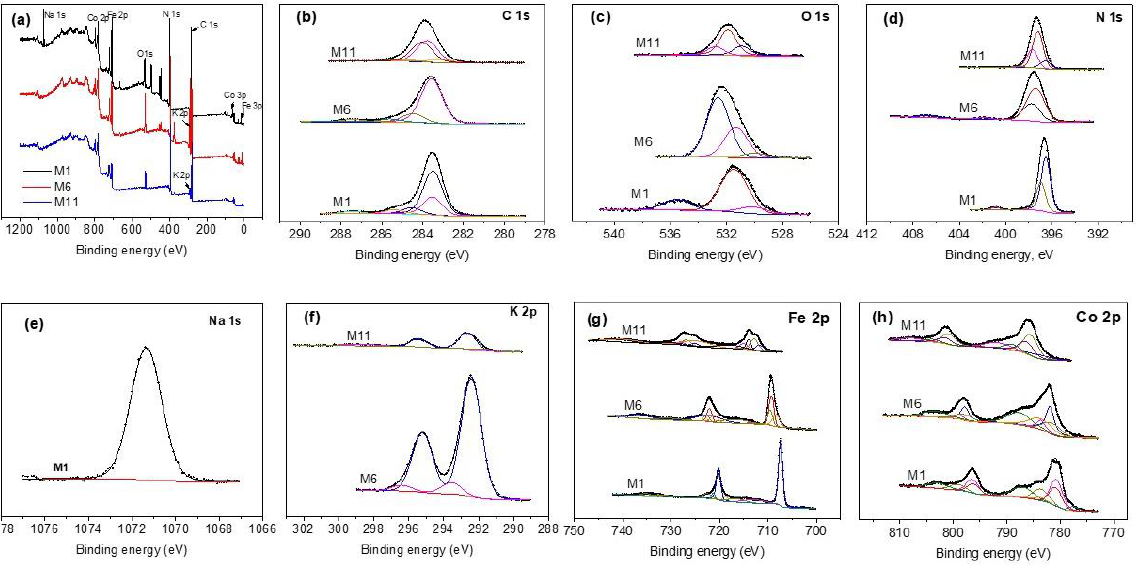
Figure 5. XPS core-level spectra on CoHCFs M1, M6, M11 ( a ) survey spectra; ( b ) C 1s; ( c ) O 1s; ( d ) N 1s; ( e ) Na 1s; ( f ) K 2p; ( g ) Fe 2p; ( h ) Co 2p.